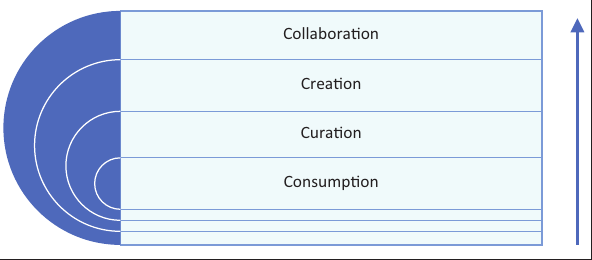
FIG URE 1 : Structured